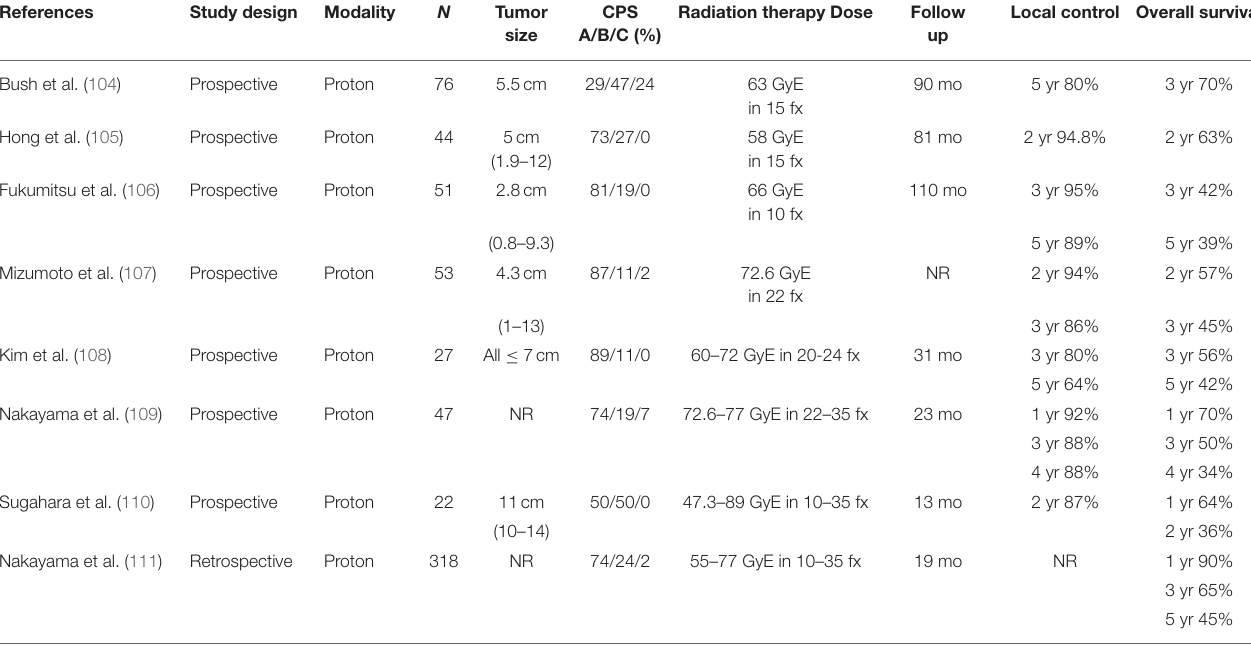
TABLE 6 | Studies of proton beam radiation therapy for hepatocellular